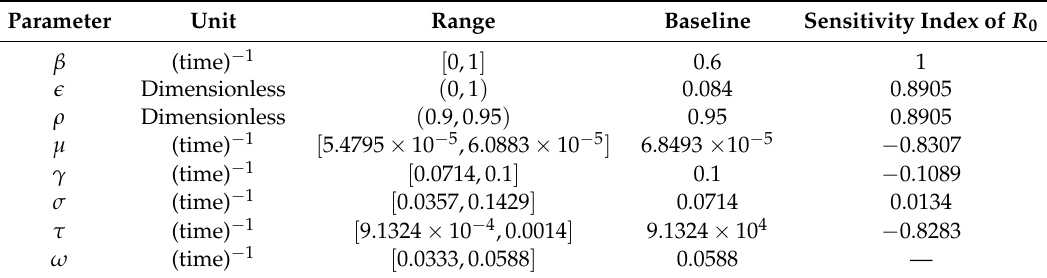
Table 2. Range of model parameters and sensitivity index of R 0